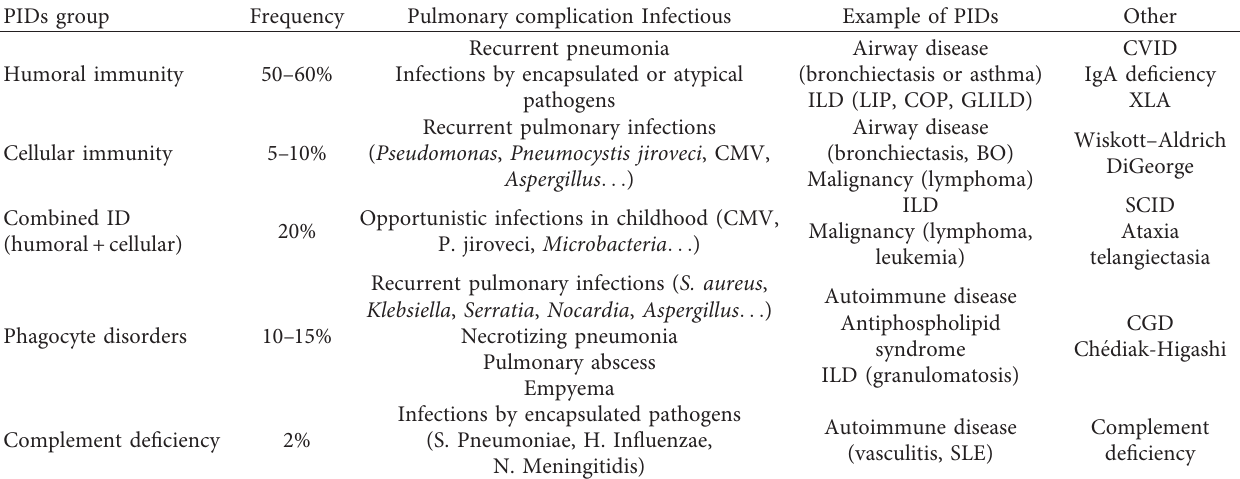
Table 2: Pulmonary complications associated with primary